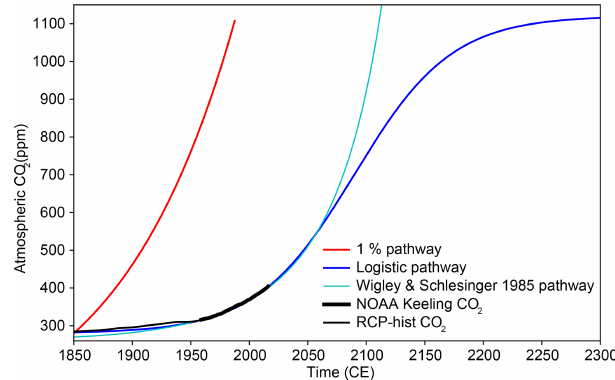
Figure 3. Historical atmospheric CO 2 trajectory and three idealized CO 2 pathways. Historical trajectories are from the CMIP5 RCP his- torical archive for 1850 to 1958 (Moss et al., 2010) and from the National Oceanic and Atmospheric Administration (NOAA) record from Mauna Loa for 1959 to 2017 (Trans and Keeling, 2017). In addition to the 4 × CO 2 , 1%, and logistic pathways, the pathway of Wigley and Schlesinger (1985) (an abandoned alternative to the 1% experiment) is